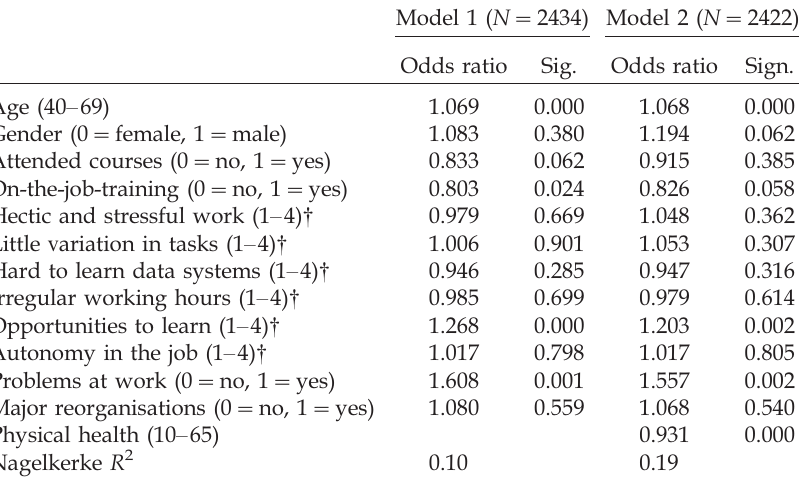
Table 7. Logistic regression of subjecti v e declining work ability by age, gender, physical and work characteristics. Employed persons 40 (cid:1) 69 years.